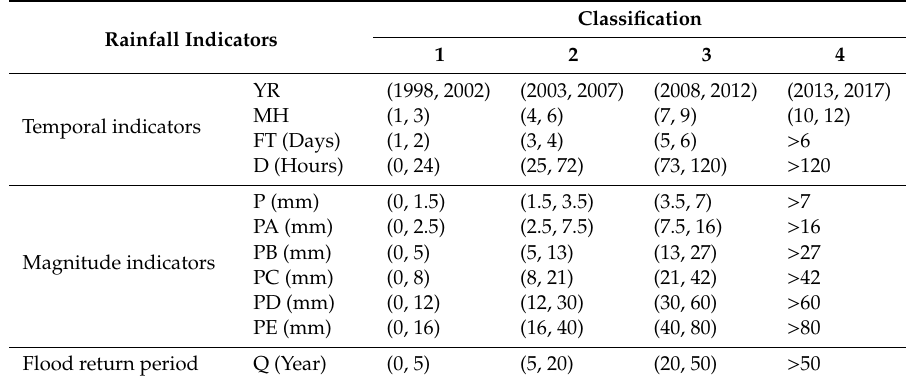
Table 2. Classification results for the flood hazard and rainfall indices.